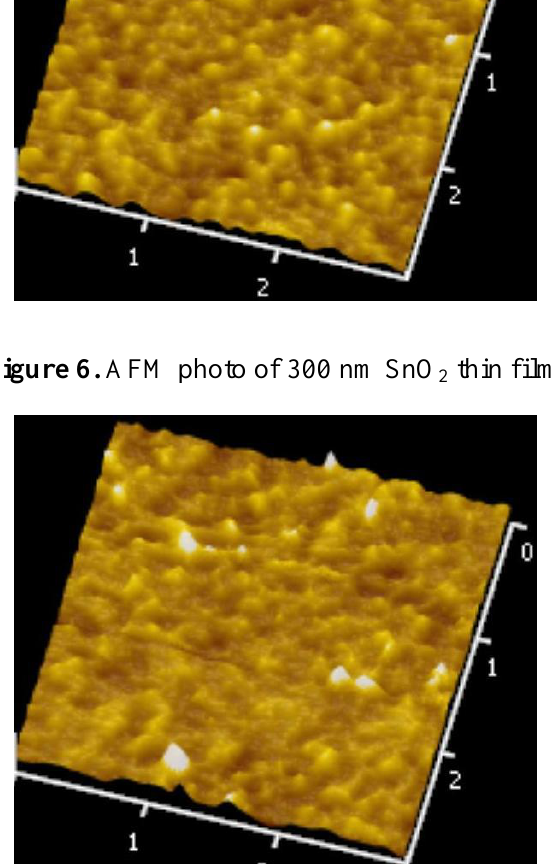
Figure 7. SEM photo of 100 nm SnO